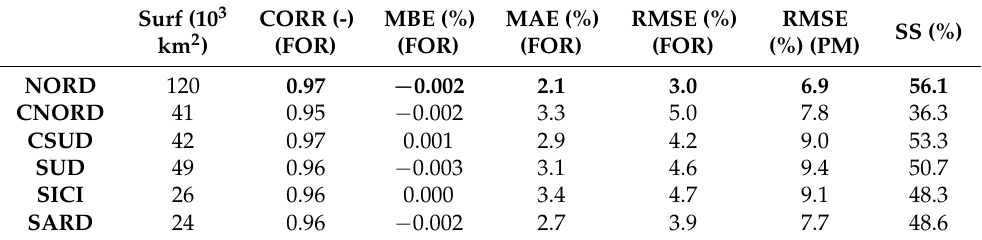
Table 3. PV power forecast accuracy metrics of the ANN hybrid model (FOR), and the RMSE of the persistence forecast (PM) obtained on the six market zones. MBE, MAE and RMSE are in percent of the PV installed capacity. In bold is the area for which the greatest improvement over PM was